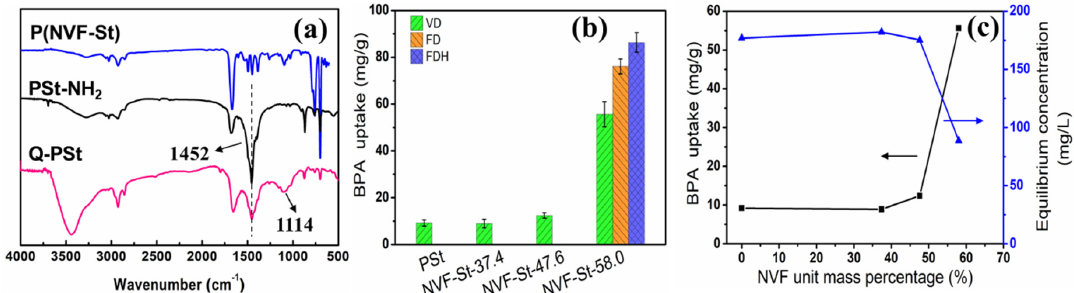
Figure 5. ( a ) FTIR spectra of P(NVF-St), PSt-NH 2 , and quaternized sample(Q-PSt). ( b ) Bisphenol A (BPA) uptake (mg / g) of NVF-St copolymers (VD: Vacuum-dried, FD: Freeze-dried, FDH: Hydrolyzed, dialyzed, and freeze-dried) and ( c ) the relationship between BPA uptake and NVF unit content in NVF-St copolymers (vacuum-dried). Adsorption condition: Copolymer 10 mg, BPA 200 mg/L, 5 mL, pH 7, 18 h, room temperature.